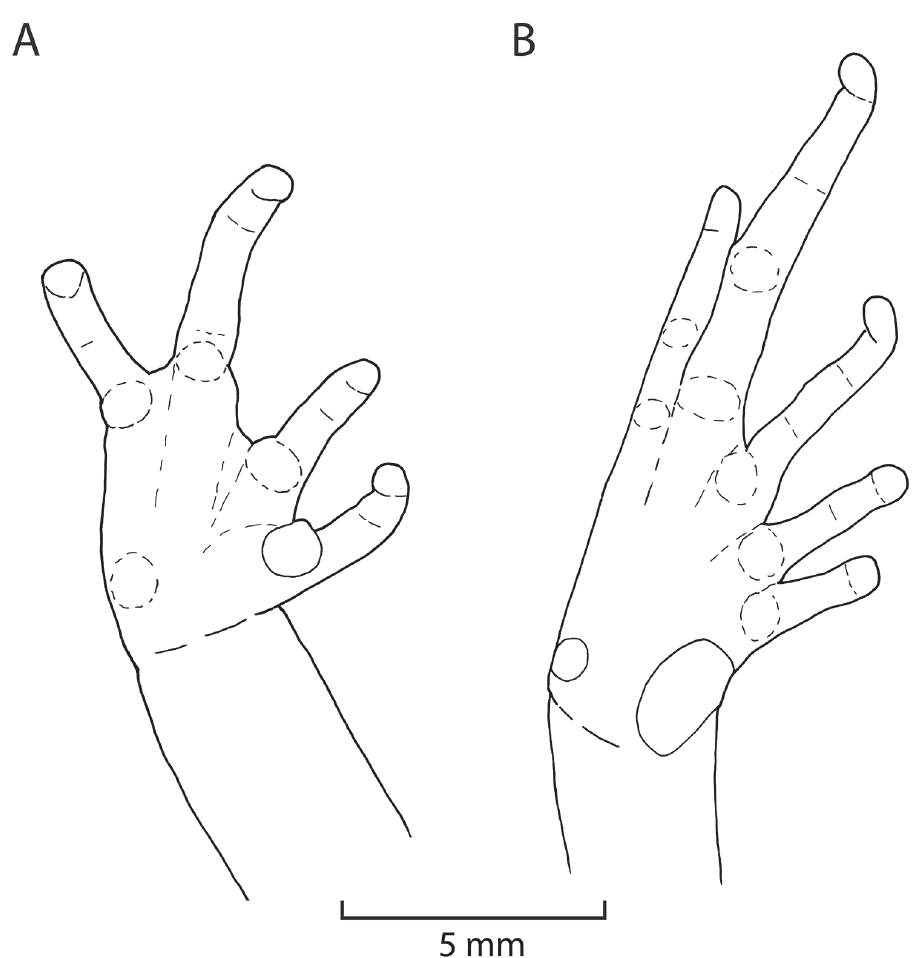
Figure 6. Ventral views of right hand ( A ) and right foot ( B ) of holotype of Phrynopus inti sp. n. (MUSM 31183) . Drawings by E.